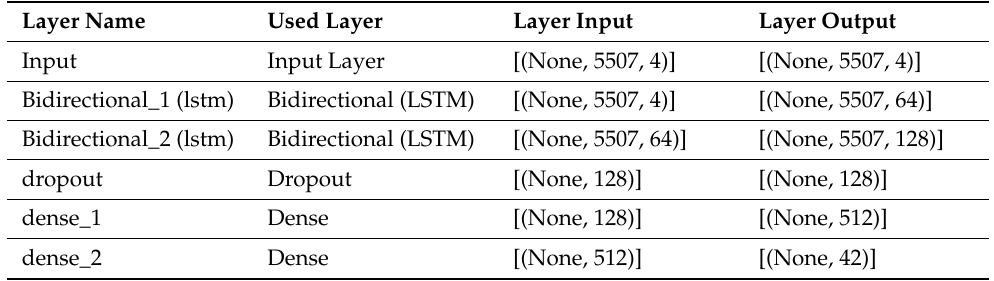
Table 2. Bi-LSTM